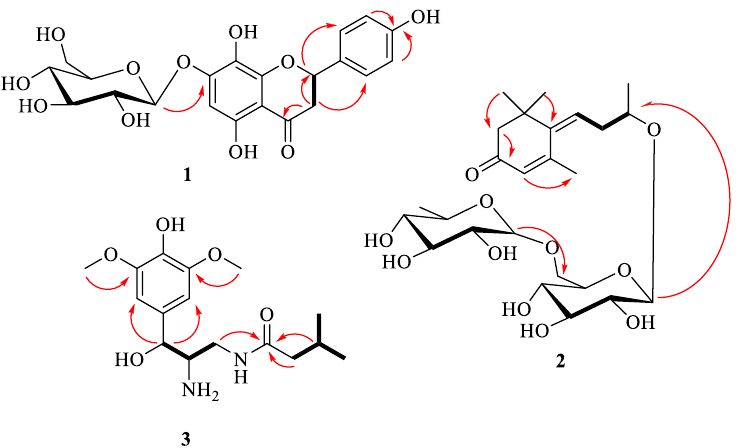
Figure 2. The key HMBC (arrow line) and 1 H- 1 H COSY (bold line) correlations of compounds 1 – 3.